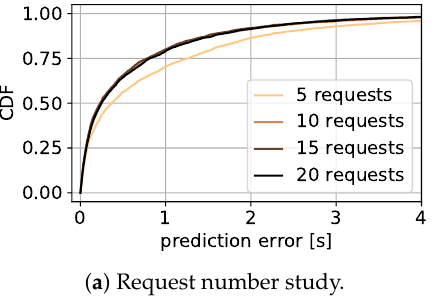
Figure 7. Initial delay prediction